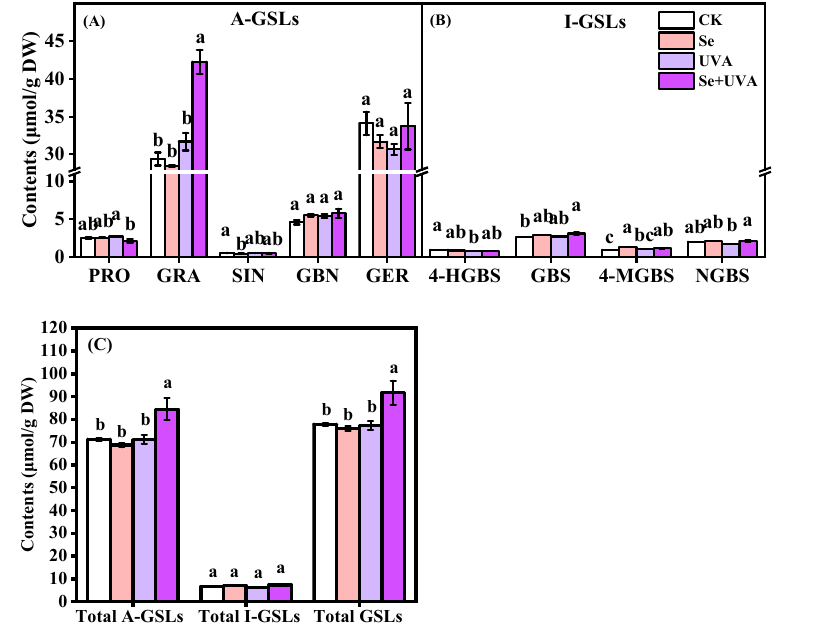
Figure 6. The contents of A-GSLs and I-GSLs content in broccoli microgreens under Se (100 μ mol/L Na 2 SeO 3 ), UVA (40 μ mol/m 2 /s), and combined treatments ( A – C ). The vertical bars indicate standard errors, n = 3. Different lower-case letters above the bars indicate significant differences between treatments by Duncan’s multiple range test at a level of 0.05.